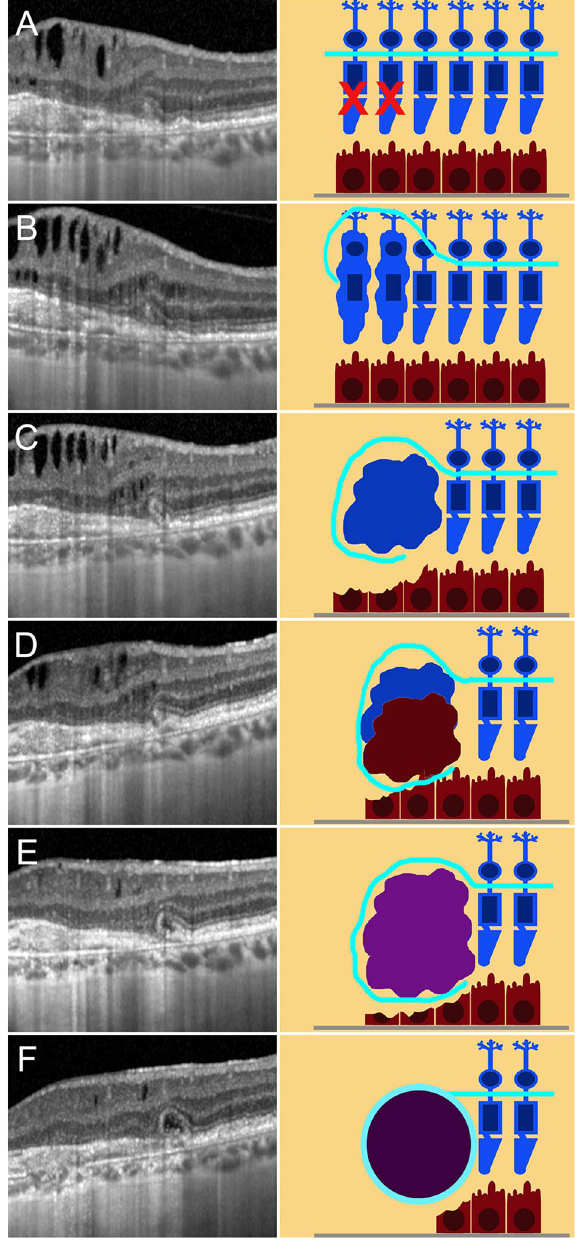
Figure 1. Simplified pathogenic mechanism of ORT development. The first step is primary photoreceptor damage ( A ), with the ELM assuming a curved shape in the proximity of photoreceptor alteration. As the photoreceptors degenerate, ELM assumes an even more evident reflected shape ( B ). ELM increases in reflectivity and thickness around the degenerated photoreceptors, becoming even more organized and assuming a scrolled shape ( C ). At the same time, the RPE cells undergo initial damage, already highlighted by an increased window effect detected at the choroidal level ( C ). RPE and remnants of the photoreceptors become partially fused in the context of the reflected ELM shape ( D ). It is worth noting that pigment is still present, as shown by the lack of window effect below the partially formed ORT ( D ). The next step is characterized by a centrifugal retraction of the partially developed ORT, with complete loss of the pigment and increased outer retinal atrophy extending below the ORT ( E ). The last step is characterized by a completely developed ORT in the ONL, well separated by a hyperreflective border, which is linked to the preserved ELM and characterized by expanded outer retinal atrophy, with hypertransmission reaching up to below the ORT ( F